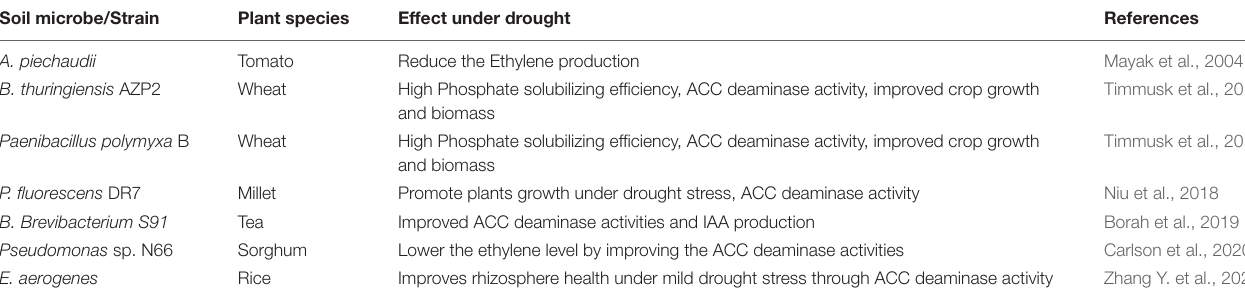
TABLE 4 | Improved ACC deaminase activity and reduced ethylene production by PGPR under drought